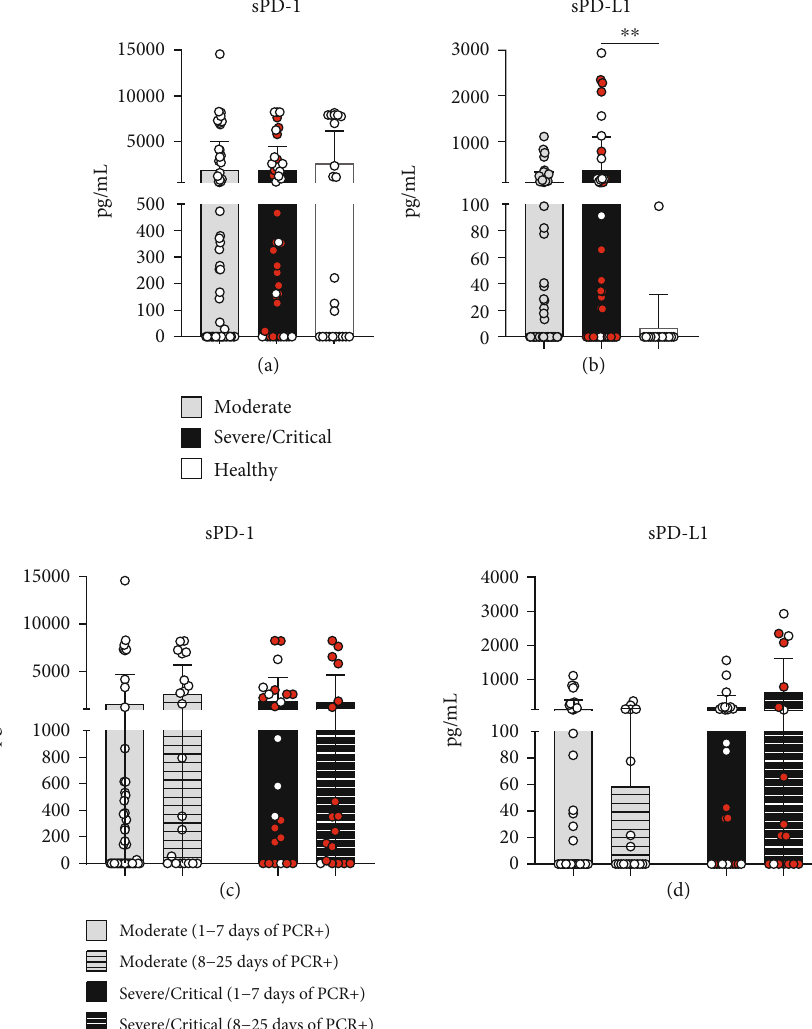
Figure 3: Increased circulant sPDL-1 levels in severe/critical COVID-19 patients. Determination by ELISA of sPD-1 (a) and sPDL-1 (b) in serum from control subjects ( n = 15 ) and moderate ( n = 69 ), severe (open symbol, n = 14 ), and critical (red symbol, n = 29 ) patients with COVID-19. sPD-1 (c) and sPDL-1 (d) at 1-7 days and 8-25 days of PCR diagnosis for SARS-CoV-2. ∗∗ P < 0 : 01